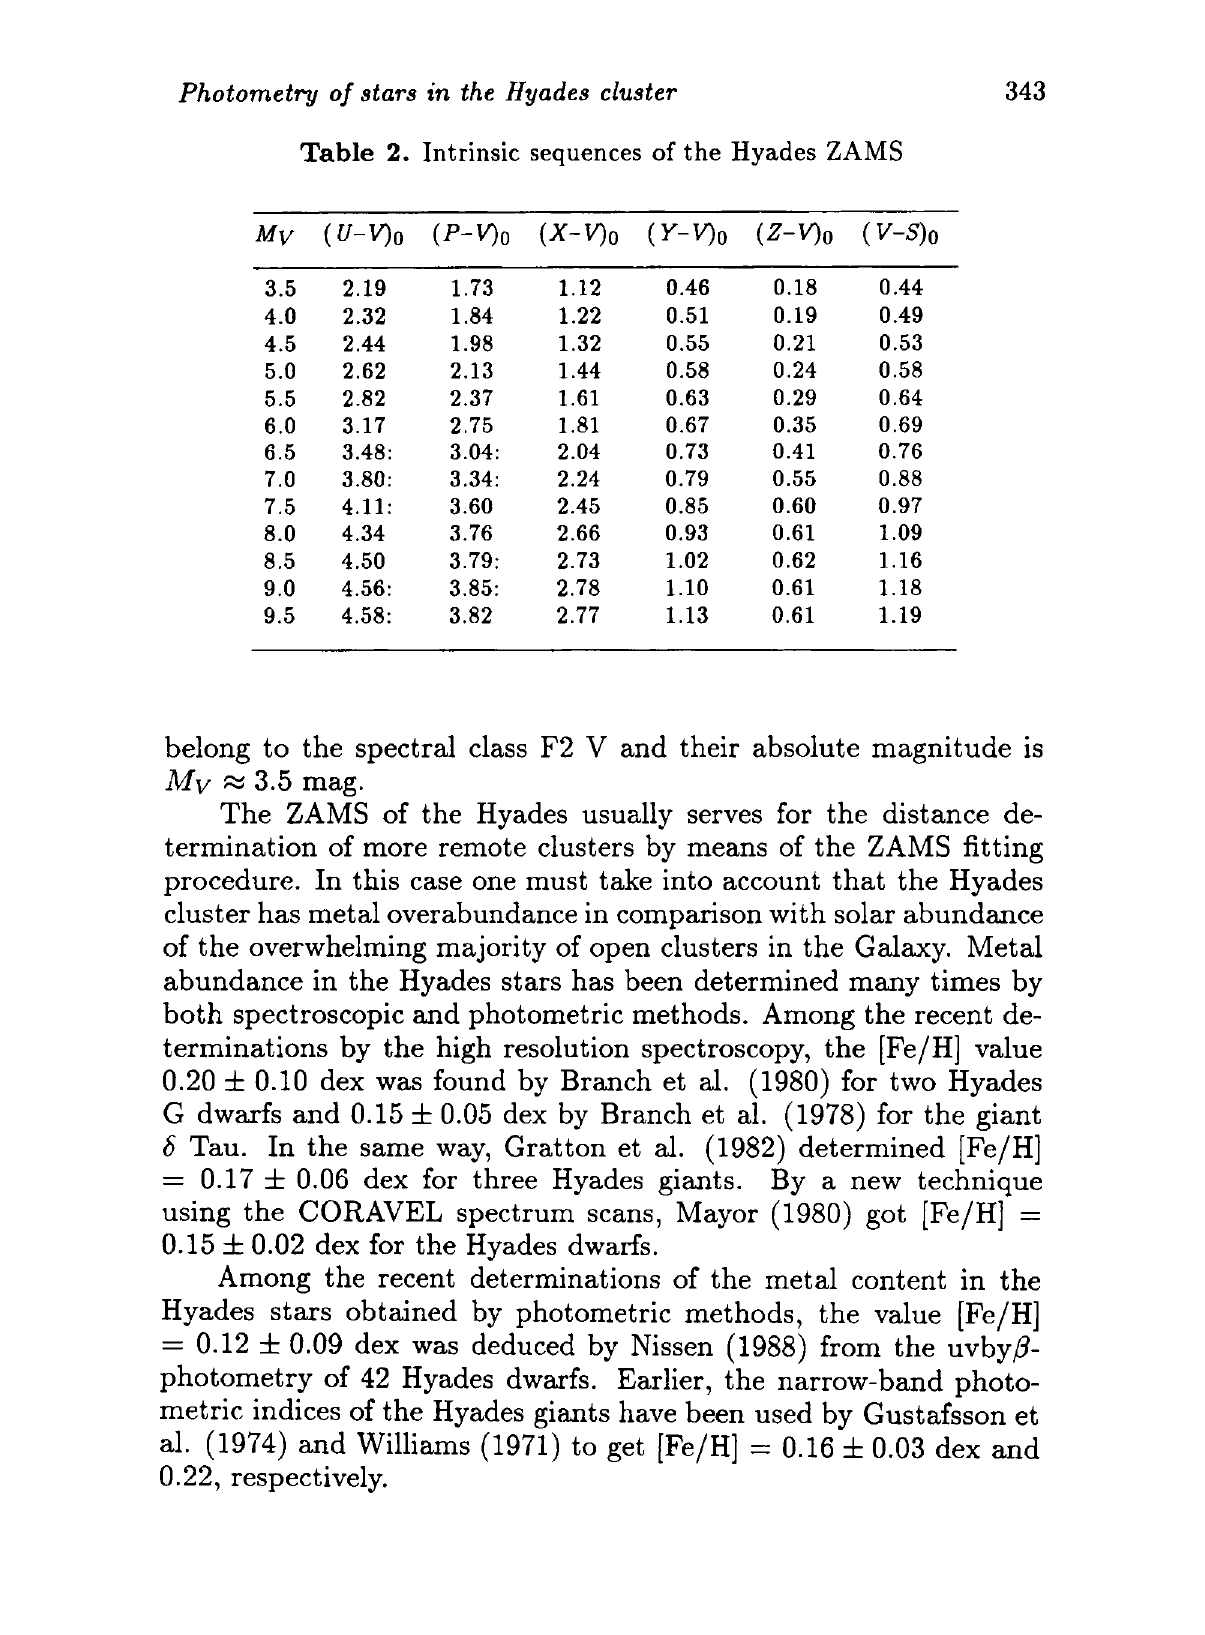
Table 2. Intrinsic sequences of the Hyades